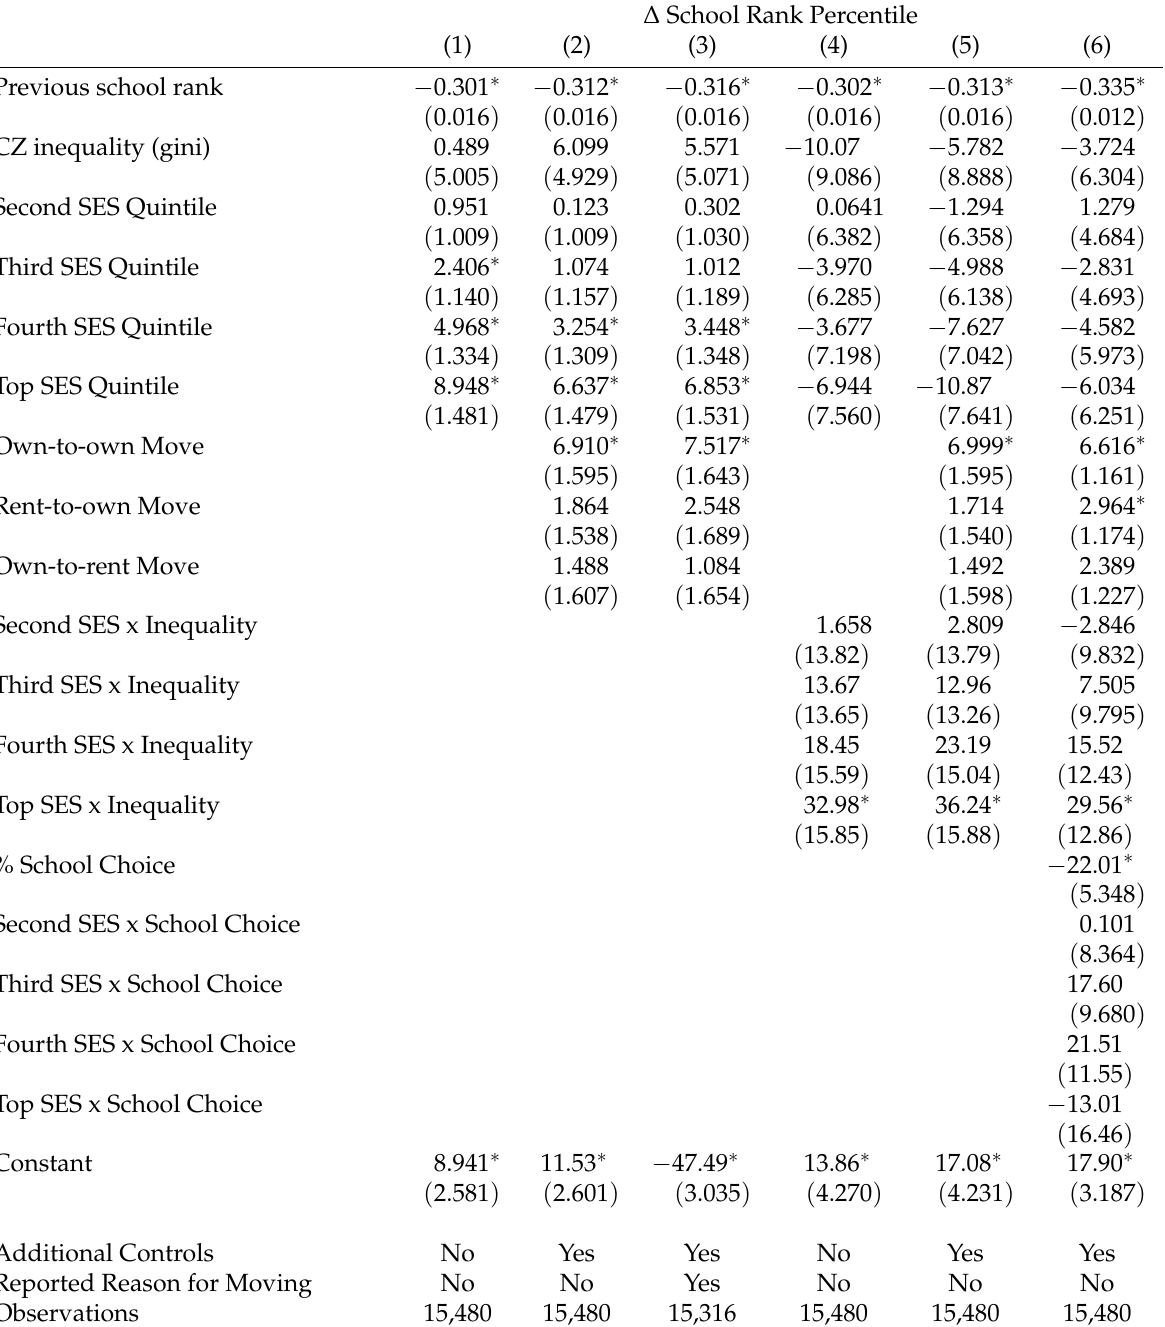
Table 1: Estimates from two-stage first difference models of change in families’ assigned school percentile